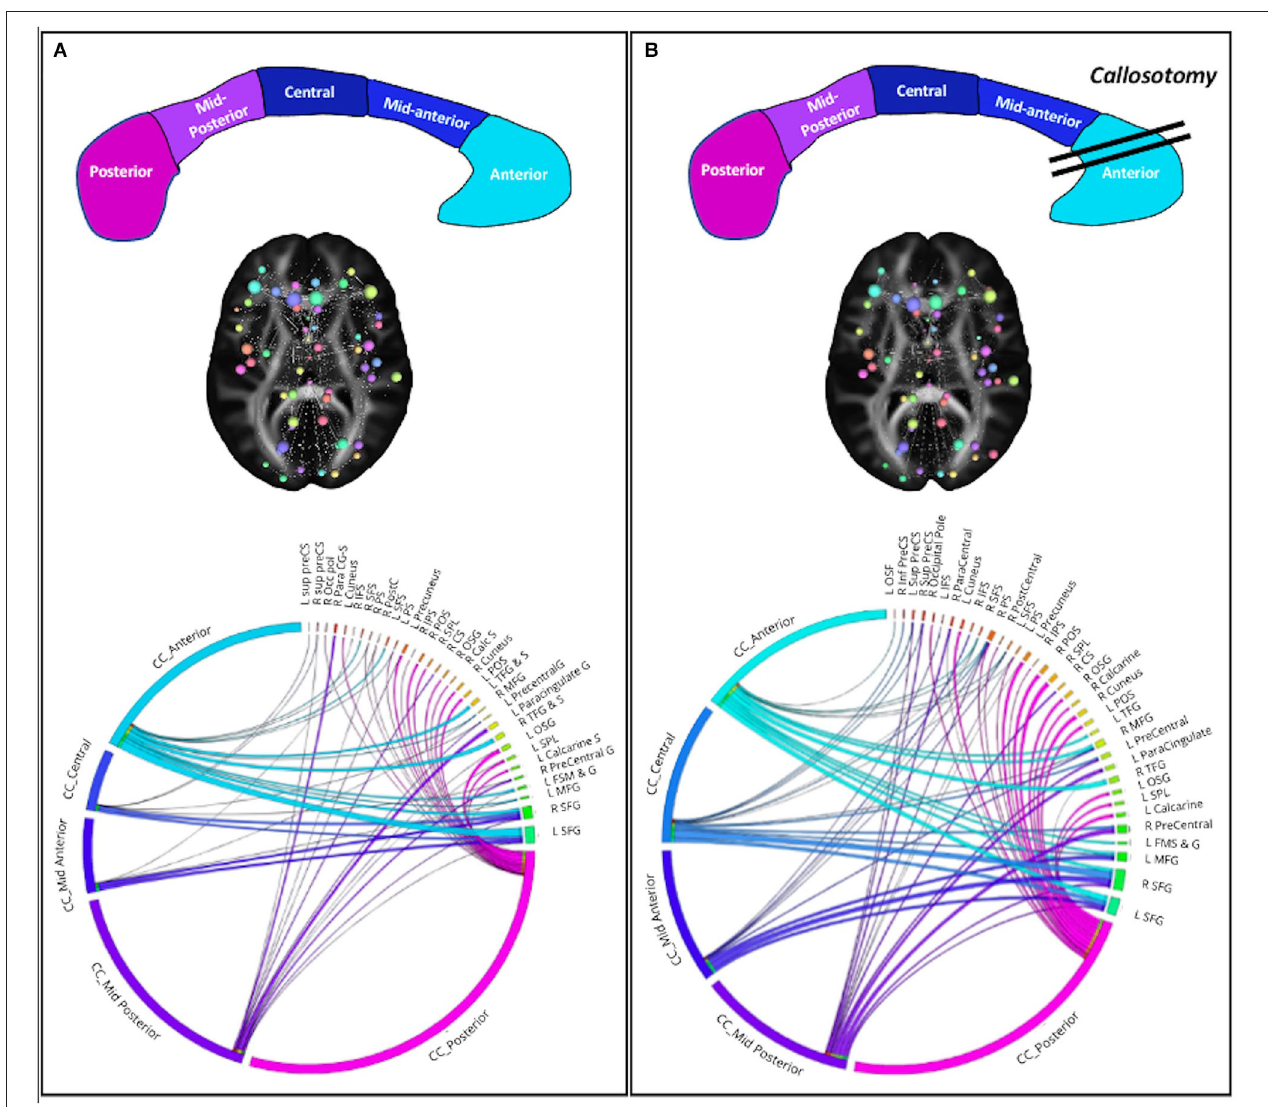
FIGURE 2 | Structural network connectivity changes. (A) Preoperative plots; (B) postoperative plots. On the top the corpus callosum subsections and surgery. CC subsections are colored as in the CC figure. On the middle the 3D graph visualization of plot connectogram. The cerebral plot shows the brain areas involved in the structural network connectivity changes. On the bottom the Circos plot shows the strength of connectivity among CC subsections and cortical